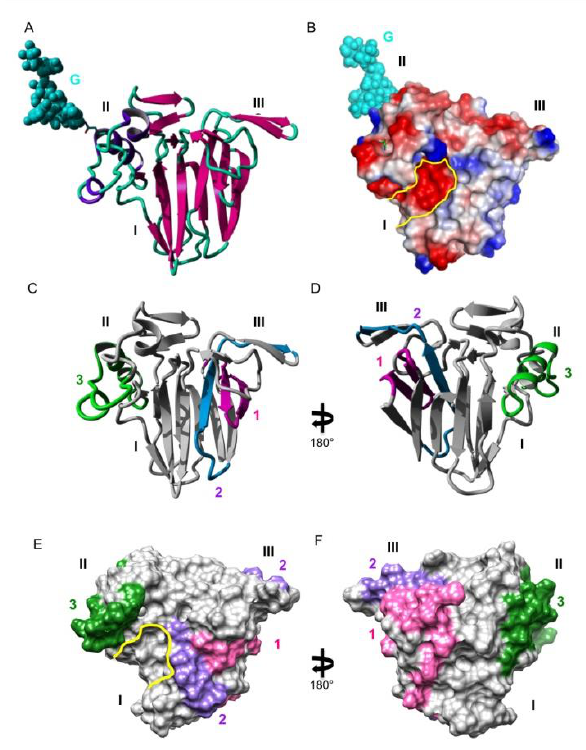
Figure 1. ( A ). Ribbon diagram of the Cup s 3 model showing the overall organization of the allergen in three distinct domains labeled I, II, and III, and the N - glycan chain (G) attached to residue Asn162 in domain II, represented in CPK colored cyan. ( B ). Molecular surface of Cup s 3 showing the electrostatic potentials patches. The electronegatively charged groove is outlined in yellow. ( C , D ). Mapping of the sequential IgE-binding epitopes 1 (colored pink), 2 (colored blue), and 3 (colored green) on the front face ( C ) and the back face ( D ) of the ribbon diagram of Cup s 3. ( E , F ). Mapping of the sequential IgE-binding epitopes 1 (colored pink), #2 (colored blue) and 3 (colored green) on the front face ( E ) and the back face ( F ) of the molecular surface of Cup s 3. Epitope 2 consists of two separate patches on the molecular surface of the TLP allergen. Note the coalescence of epitope 1 with both patches of epitope 2.